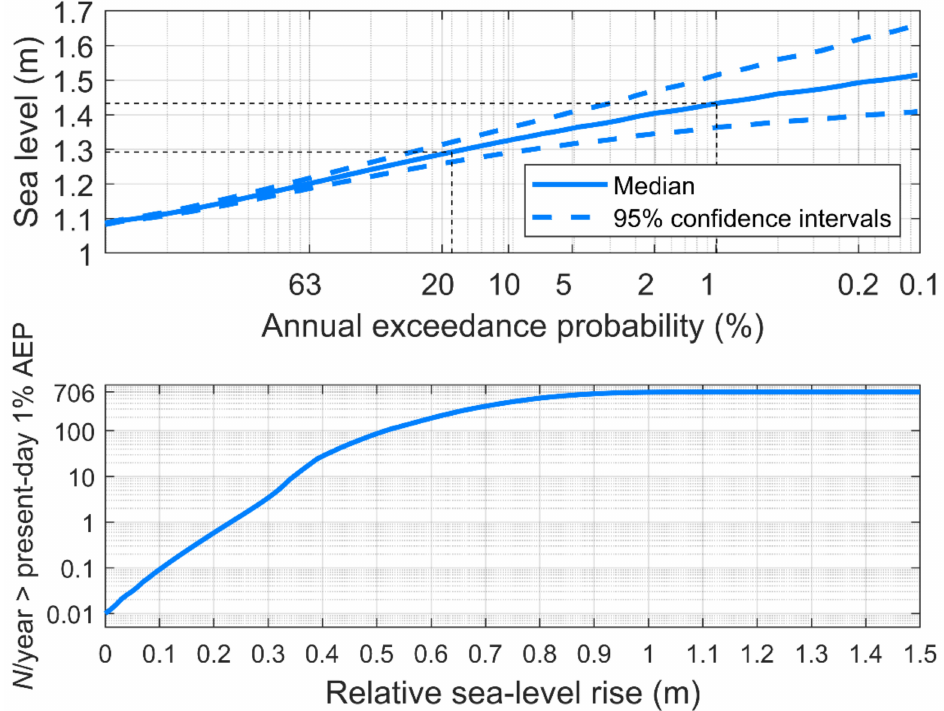
Figure 2. Upper plot: extreme sea-level distribution from the Moturiki Island (Figure 1) sea-level gauge. Lower plot: Increase in the number (N) of sea-level events per year reaching or exceeding the present-day 1% annual exceedance probability (AEP) elevation, with relative sea-level rise. The lower plot saturates at 706 high tides per year all exceeding the present-day 1% AEP sea-level